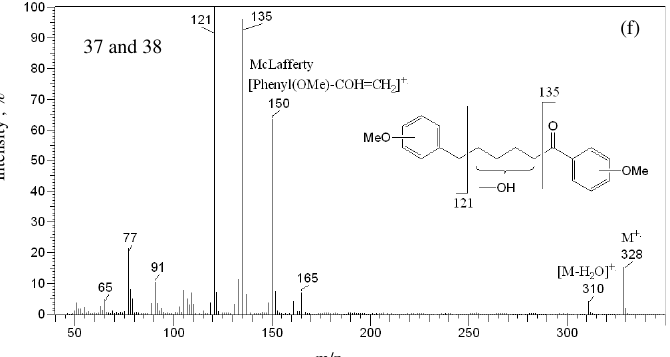
Figure 4 . Spectra, structures and important fragments of new aromatic compounds (a) 28 , (b) 33 , (c) 34 , (d) 35 , (e) 36 , (f) 37 and 38 found in manuka honey